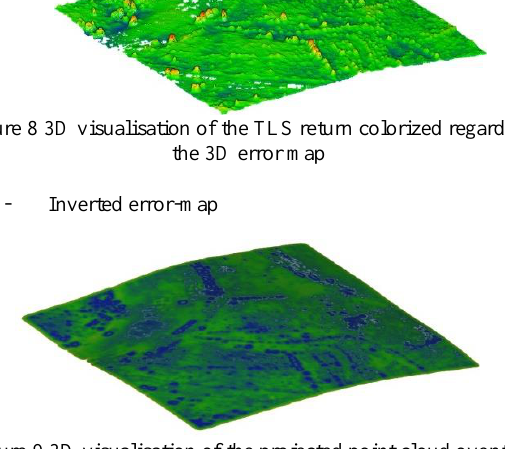
Figure 9 3D visualisation of the projected point cloud over the reference colorized regarding inverted error